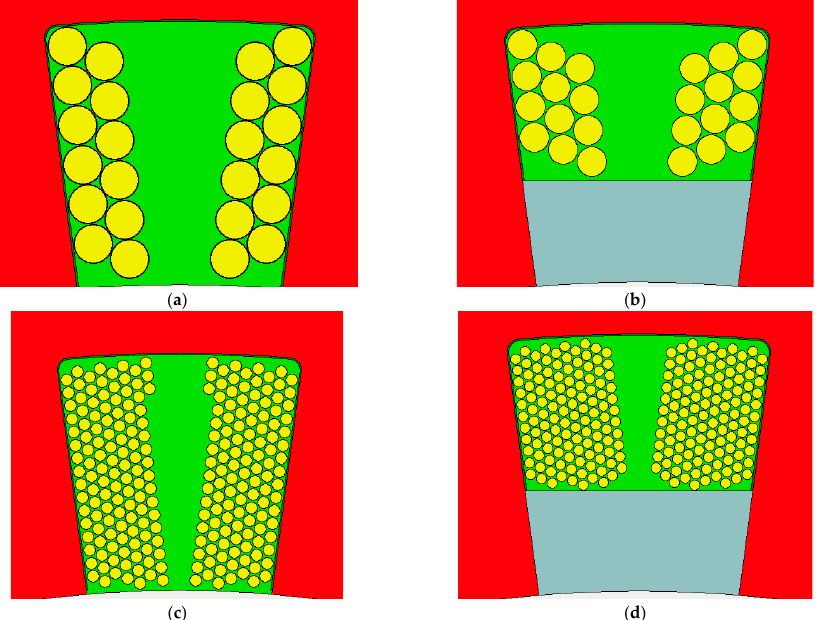
Table 3. Correlation analysis of airgap thickness and PM thickness with the AC losses.